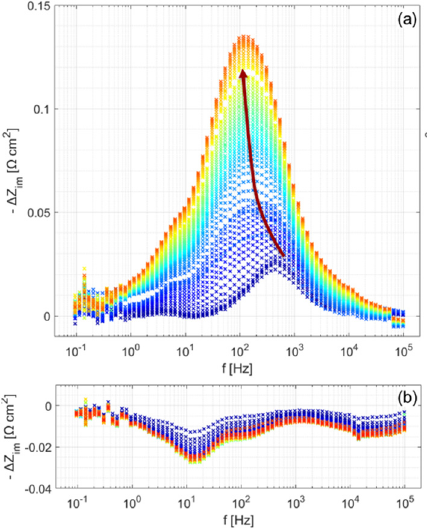
Figure 8. Differences of EIS (Bode plot) over time for ( a ) ceramic SoA cell and ( b ) metal supported cell. The initial EIS was subtracted from all spectra at the specific operating time. Ceramic cell operated at 650 ◦ C, − 0.25 A/cm 2 . The frequency of recording was every 12 h during the first 100 h, followed by every 8 h for 140 h, and finally every 6 h for the last period. Increasing operating time from blue to red curves (arrow).